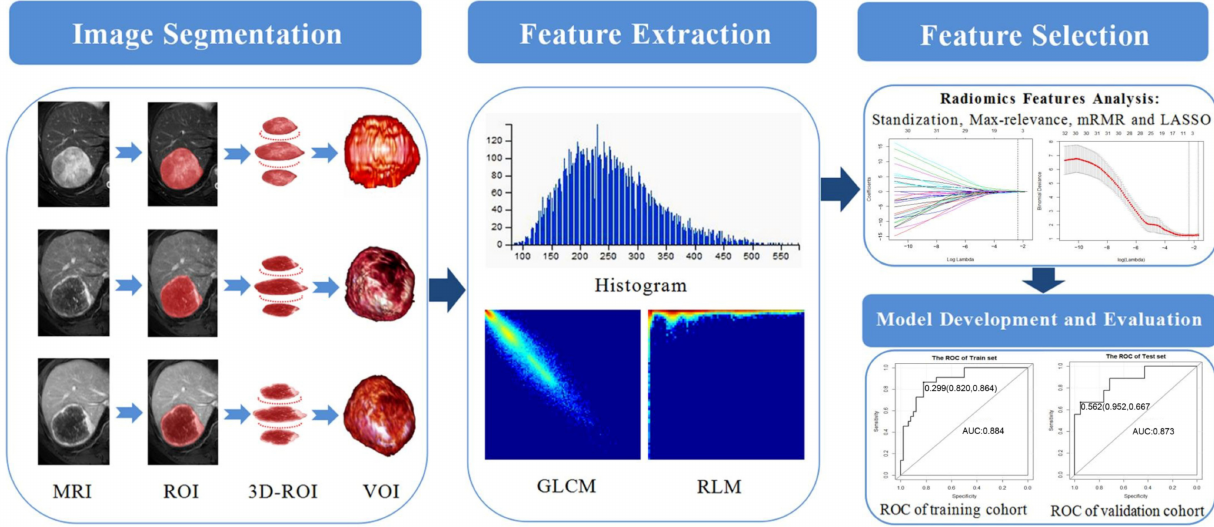
Figure 2. Schematic diagram of the processing and analysis flowchart. ROIs were manually delineated over the whole tumour layer by layer on T2WI, AP, and PVP images and automatically merged into a VOI. Radiomics features were extracted automatically using Artificial Intelligence Kit software. Standardisation, max-relevance, mRMR, and LASSO analyses were used to reduce the redundancy or selection bias of the features. Finally, different models were constructed and verified. MRI, magnetic resonance imaging; ROI, region of interest; VOI, volume of interest; GLCM, grey-level cooccurrence matrix; RLM, run-length matrix; mRMR-40, max-relevance and min-redundancy; LASSO, least absolute shrinkage and selection